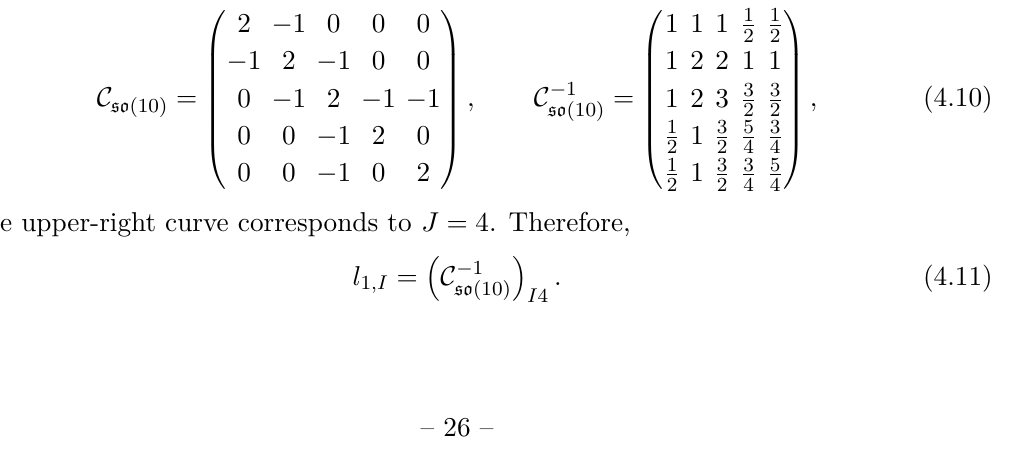
Dynkin diagram. The numbers within 5